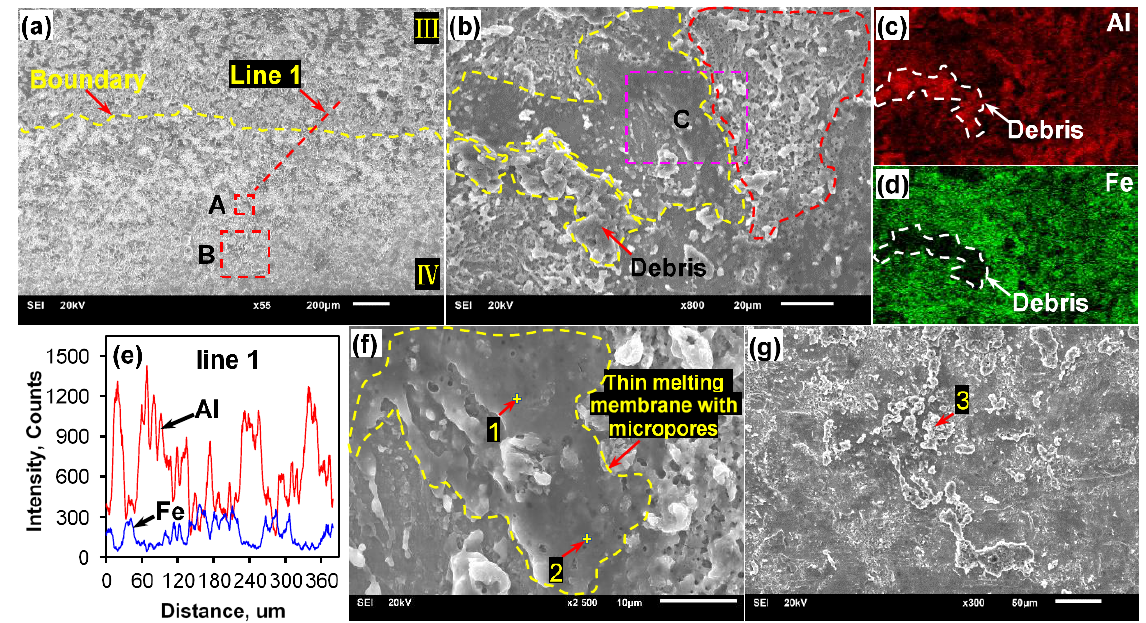
Figure 5. The evolution of the melting feature and porous structure in layer IV: ( a ) A low-magnification SEM image showing layers III and IV; ( b ) a magnified view of area ‘A’ in ( a ), showing the melting feature and hierarchical porous structure; ( c , d ) EDS elemental maps of ( b ); ( e ) EDS result along line 1 in ( a ); ( f ) a further magnified image of area ‘C’ in ( b ), exhibiting an architecture of thin membrane covering micropores; ( g ) a magnified image of area ‘B’ in ( a ), showing the debris